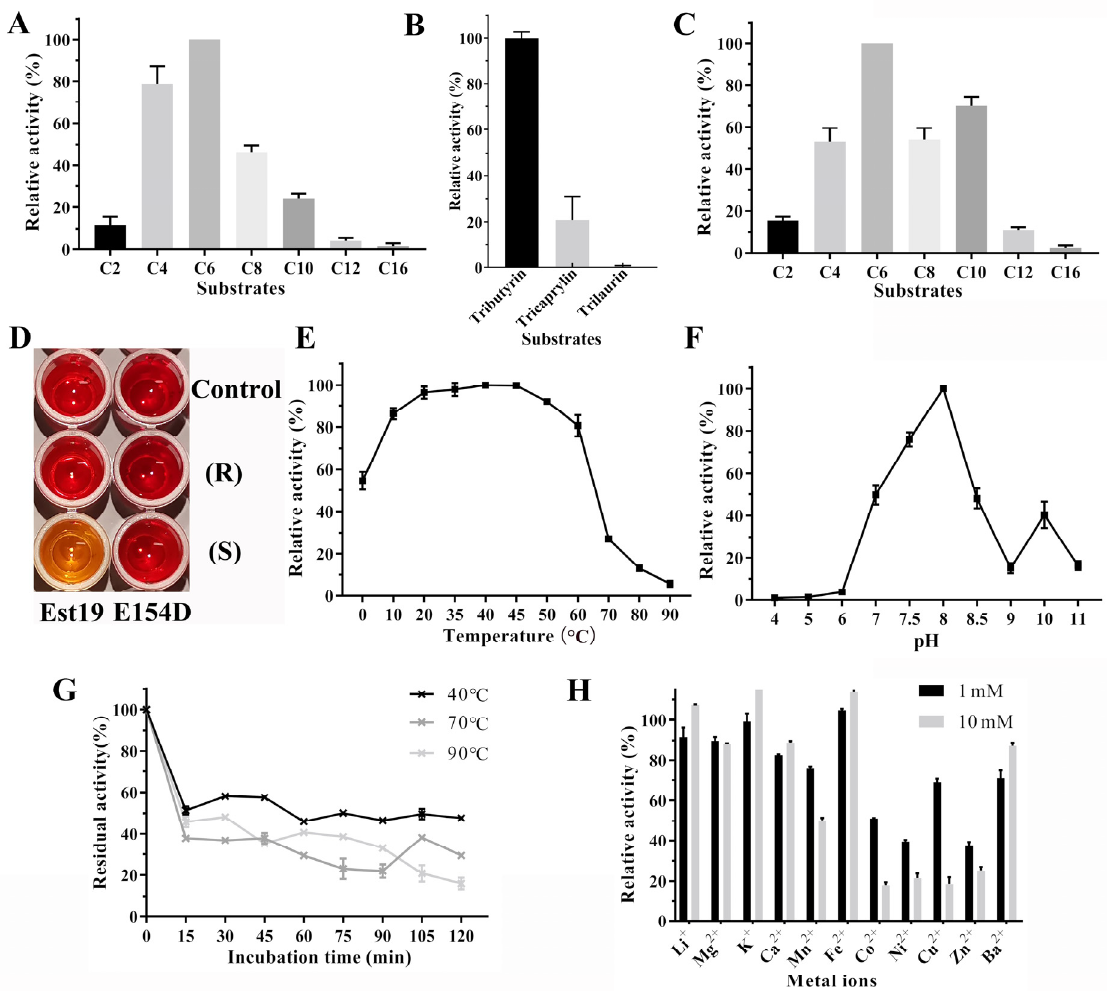
Figure 4. Biochemical characterization. ( A ) Substrate specificity of Est19. ( B ) Relative lipase activity of Est19 towards tributyrin, tricaprylin, and trilaurin. ( C ) Substrate specificity of E154D substitution. p NP esters (C2, C4, C6, C8, C10, C12, and C16) were used to determine the substrate specificity. ( D ) The hydrolysis activity of Est19 and E154D substitution toward methyl-L lactate or methyl-D lactate. The appearances of yellow color indicated the hydrolysis of the substrate. ( E ) Effect of temperature on the activity of Est19. ( F ) Effect of pH on the activity of Est19. ( G ) Thermostability assay. The enzyme was incubated at 40 ◦ C, 70 ◦ C, and 90 ◦ C for different time and then residual activity was measured. ( H ) Effect of metal ions on the activity of Est19. Table 1. Kinetic parameters of esterase Est19 and E154D variant for pNPC6 a .